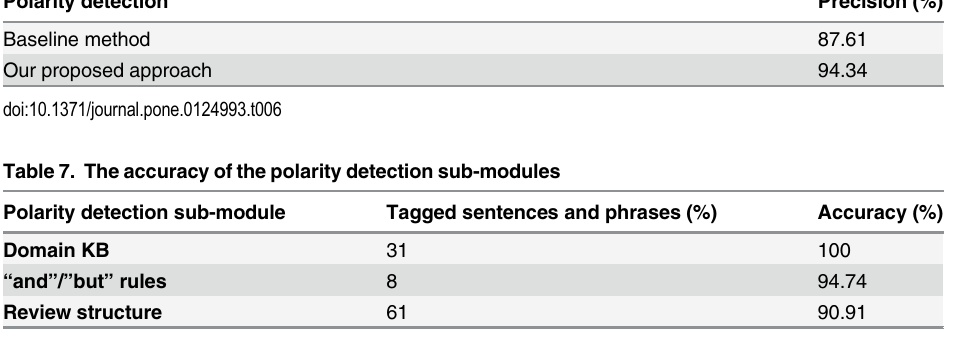
Table 6. Performance of the polarity detection module, and comparison with the performance of the baseline method Polarity detection